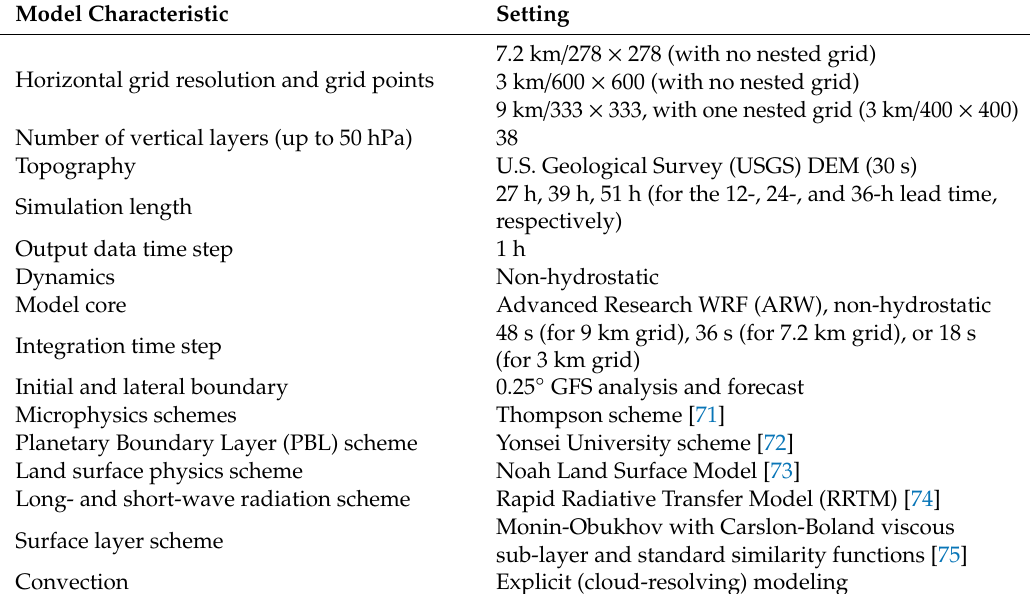
Table 1. Summary of the WRF model